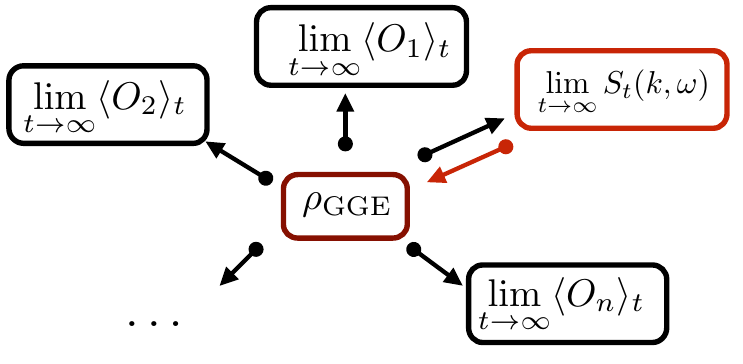
Figure 1: A GGE steady state ρ determines (black arrows) the expectation value of any GGE local operator O in the long time limit and, in particular, also the dynamical structure factor i ( k , ω ) . In this work we show that, given the dynamical structure factor in the long S lim t →∞ t time limit after the quench, one can use its behavior at small momentum k → 0 to fully reconstruct the GGE steady state (reversed red arrow) and, thus, the expectation value of any other local operator in the same stationary